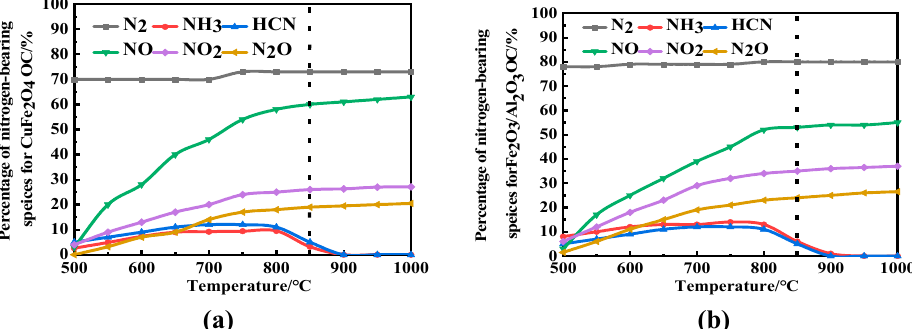
Figure 4. The variation trend of sulfur-containing substances during coal CLC with ( a ) CuFe 2 O 4 and ( b ) Fe 2 O 3 /Al 2 O 3 with different reaction temperatures.